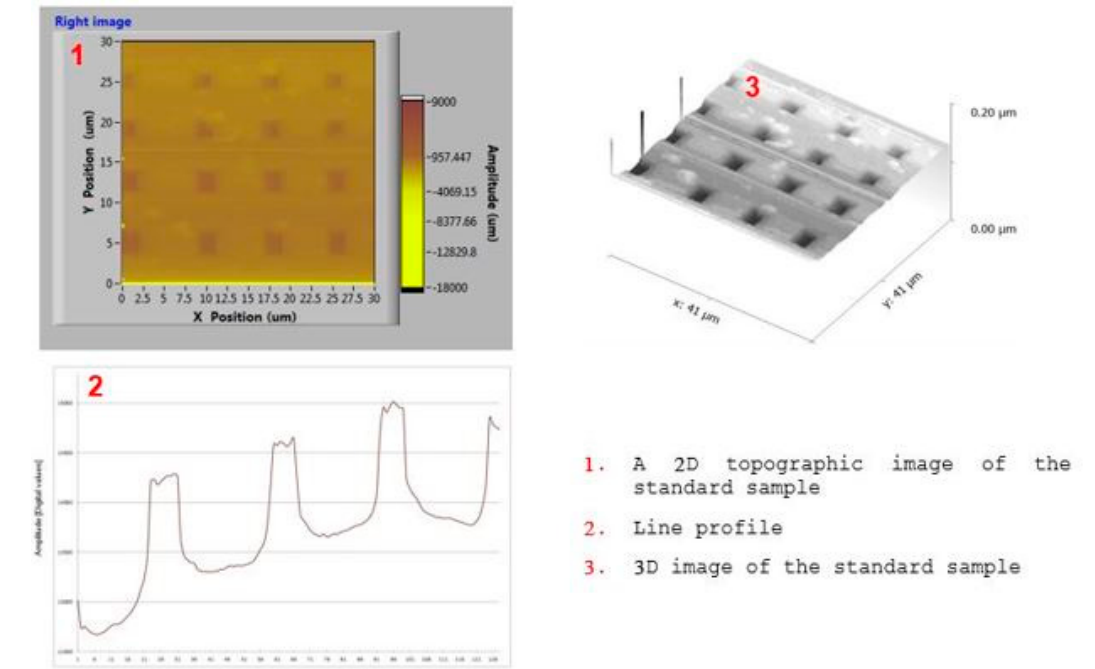
Figure 14. Non-contact atomic force microscopy (AFM) imaging of calibration sample.